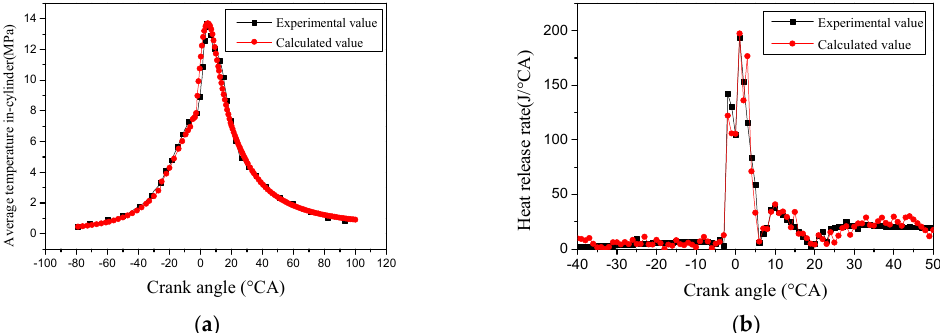
Figure 3. Comparison of calculated and measured values e in subcritical working conditions. (a) cylinder pressure (b) heat release rate.